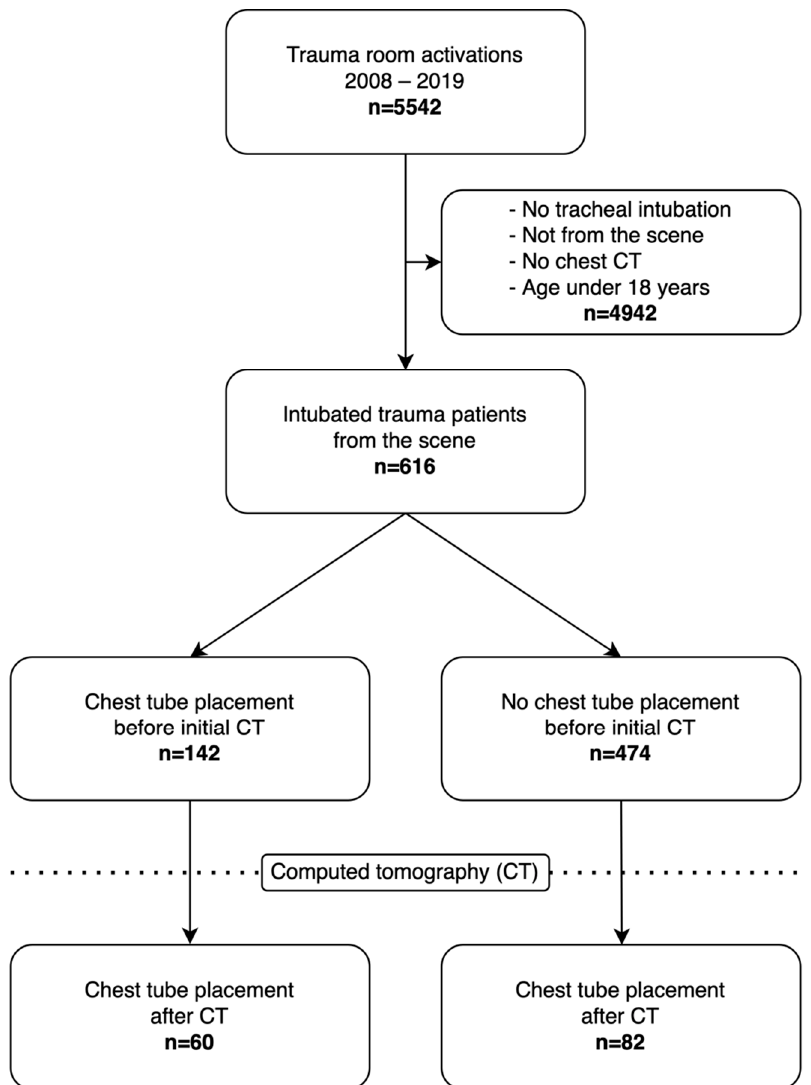
Figure 1. Study flowchart. Figure 1. Study Table 1. Baseline characteristics of patients with and without chest tube placement.